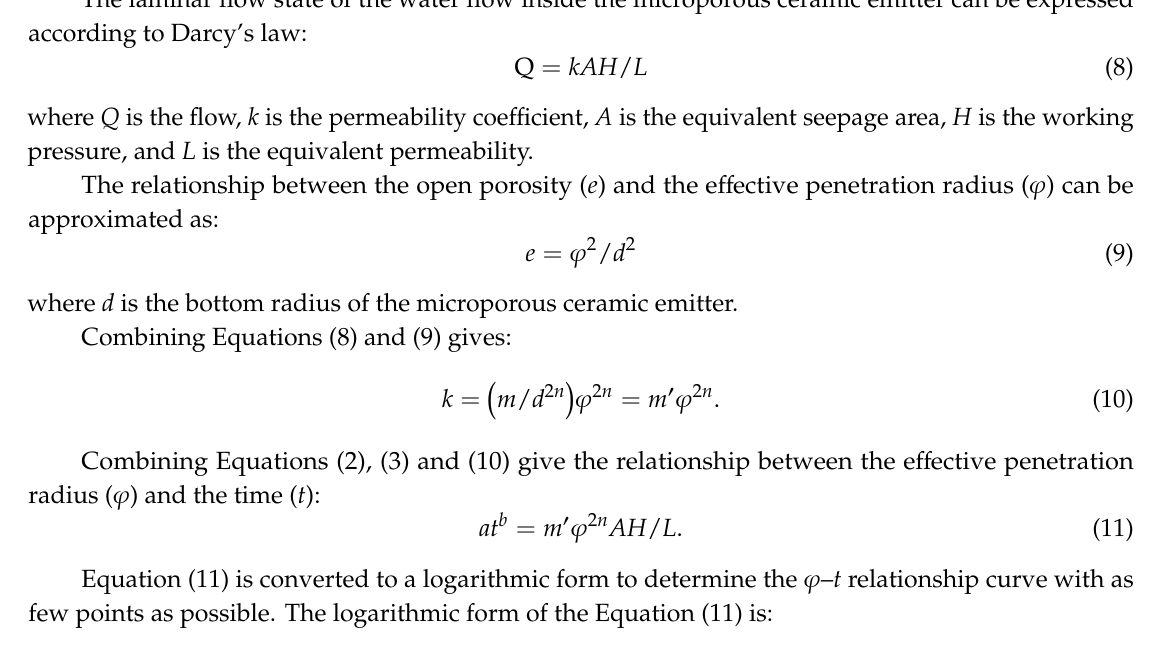
Figure 10. Schematic diagram of effective penetration radius change.